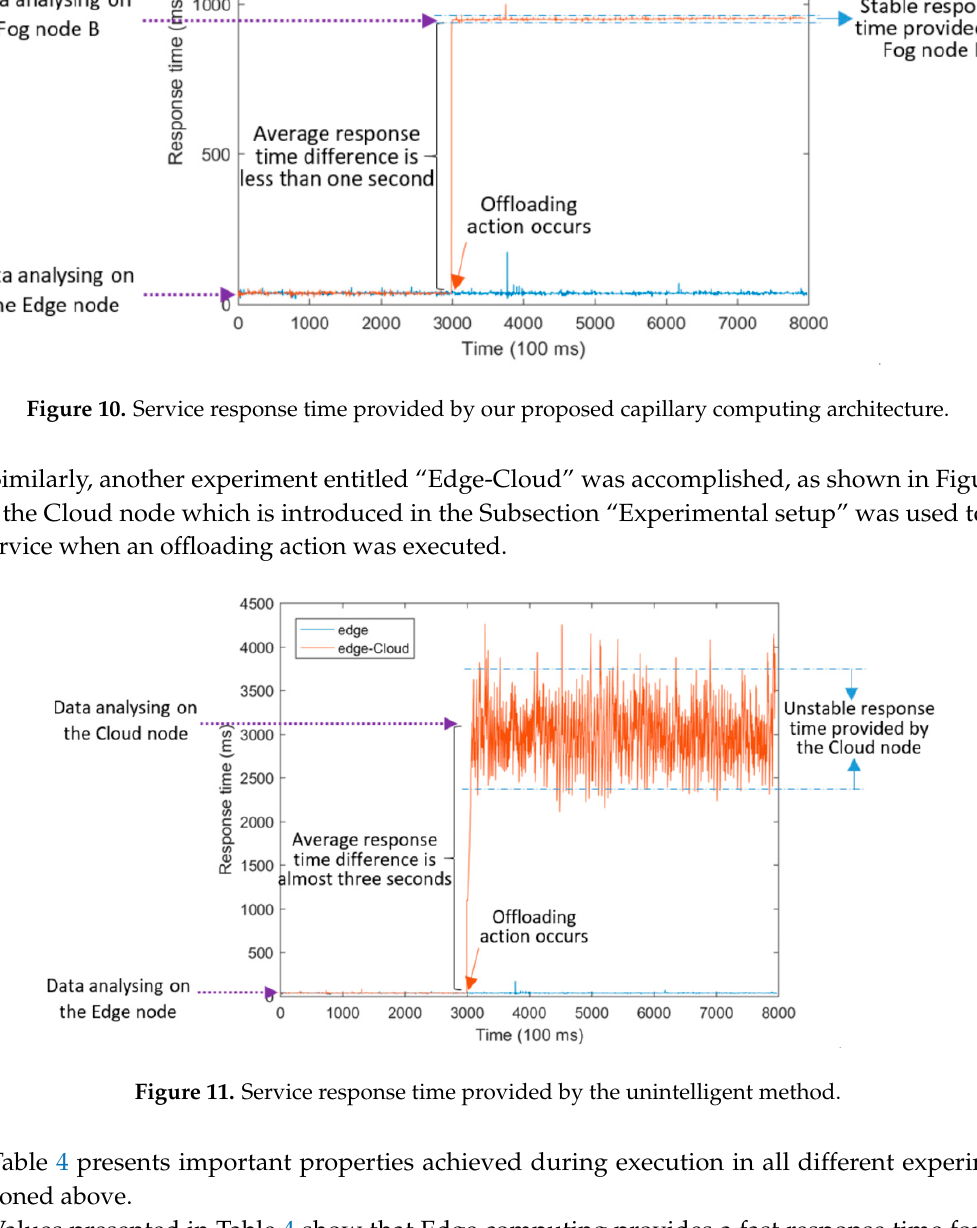
Table 4. Properties achieved in all different experiments.